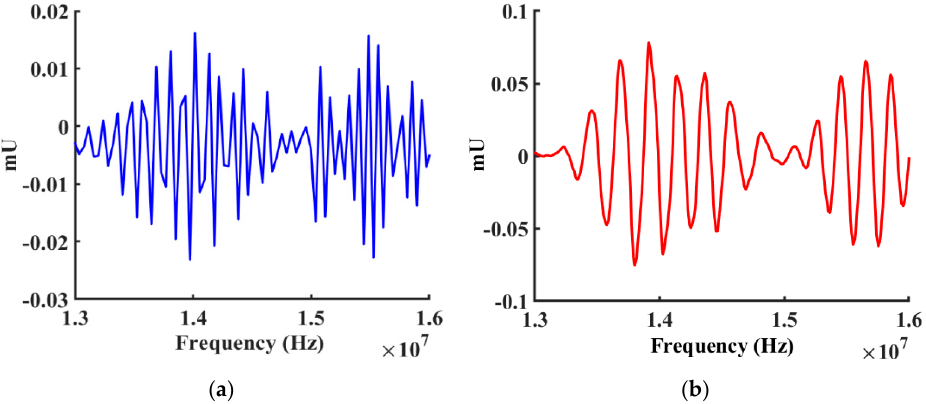
Figure 11. Comparison between simulated (Blue) and measured (Red) imaginary magnitudes for the frequency response of the device (with Cr IDTs only) from 12 MHz to 16 MHz. ( a ) Simulated imaginary magnitude of the response from the design. ( b ) Measured imaginary magnitude of the response from the fabricated device.